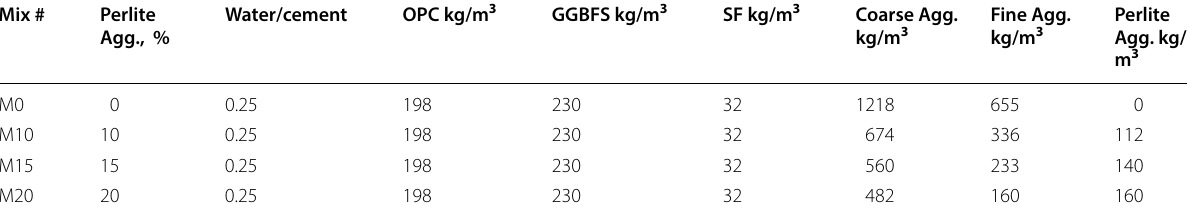
Table 3 Constituent materials used for preparing concrete containing perlite aggregate. Mix # Perlite Agg.,